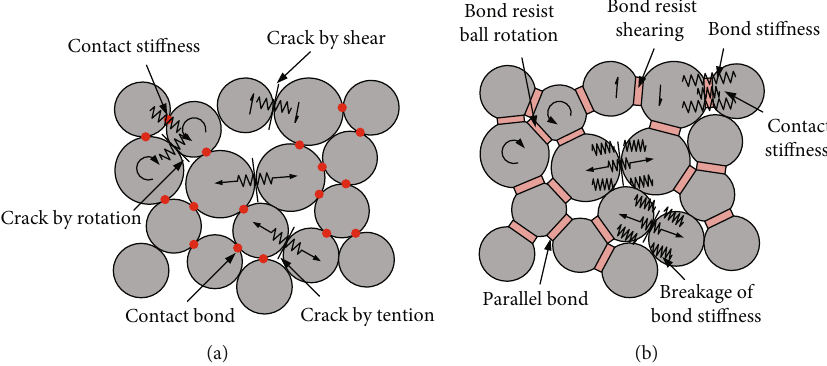
Figure 2: Cohesive model and its micromechanical behavior schematic diagram [7, 25, 26]: (a) contact bonds re fl ect the normal and tangential interactions (forces) between particles; (b) parallel bonds transmit both the force and the